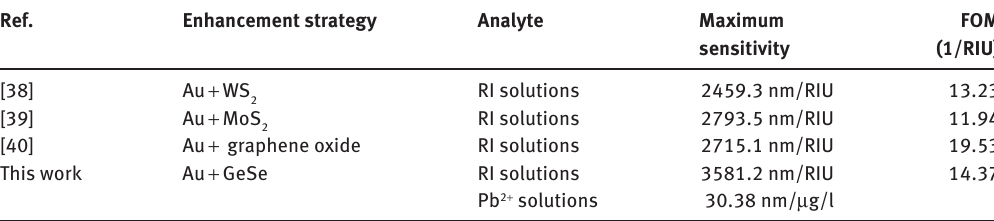
Table 1: Comparison of the latest literatures of the enhancing methods for SPR sensing performance.